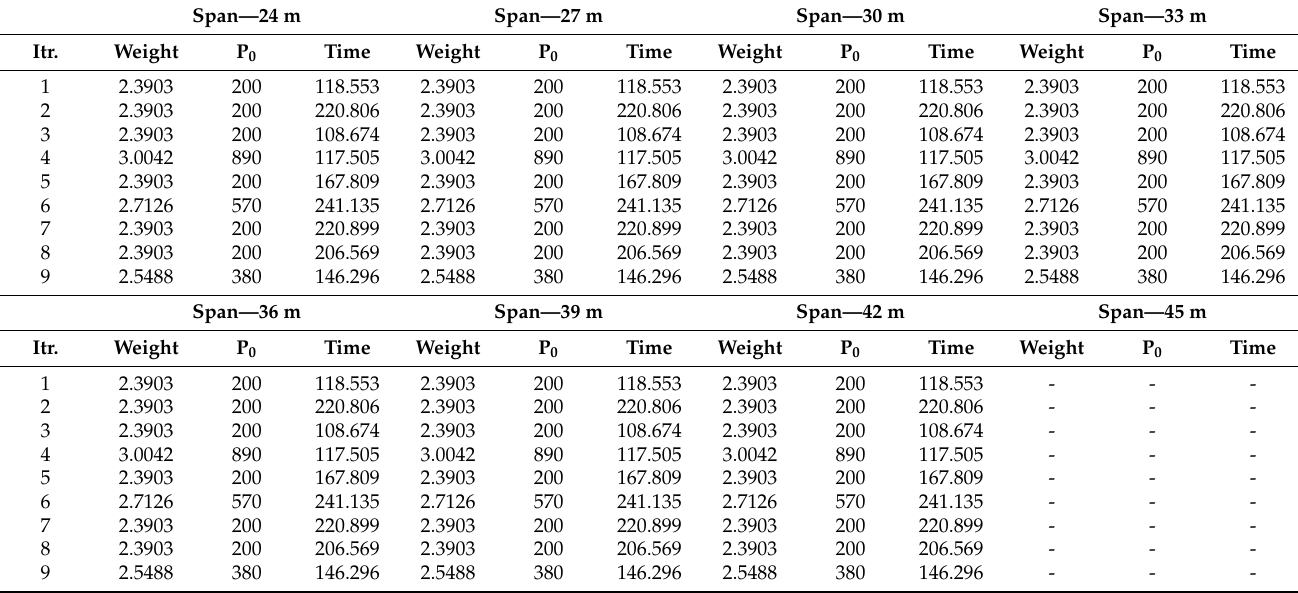
Table 5. Optimization results of the weights of the new truss at different spans.